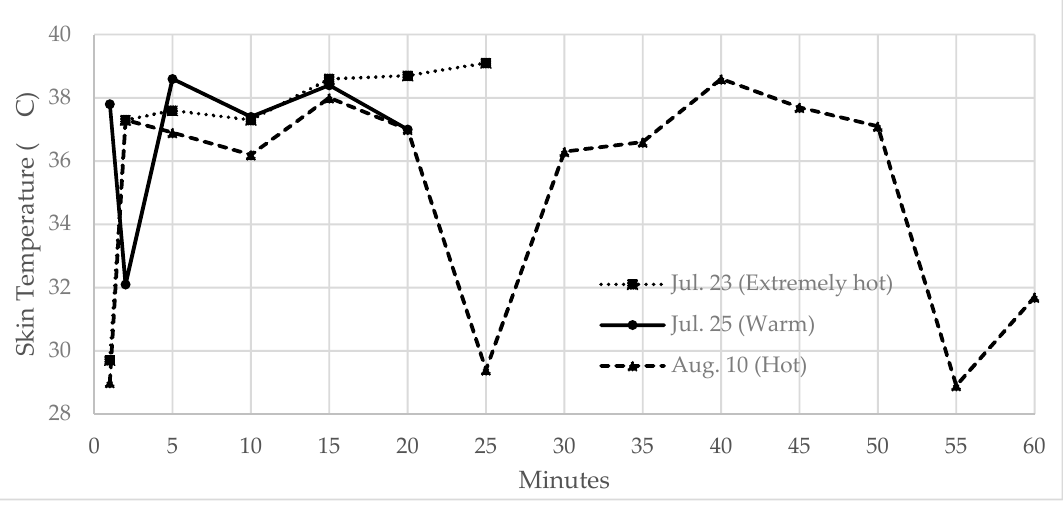
Colors representing levels of thermal perception are based on the color index in Table